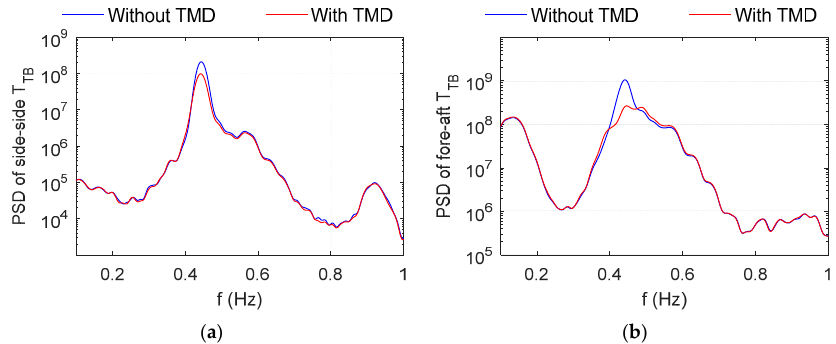
Figure 9. Power spectral density of tower base moments under rated operation condition with and without TMD: ( a ) Side–side; and ( b ) Fore–aft. Table 8. Comparison of TMD performances between spar and semi-submersible foundations.